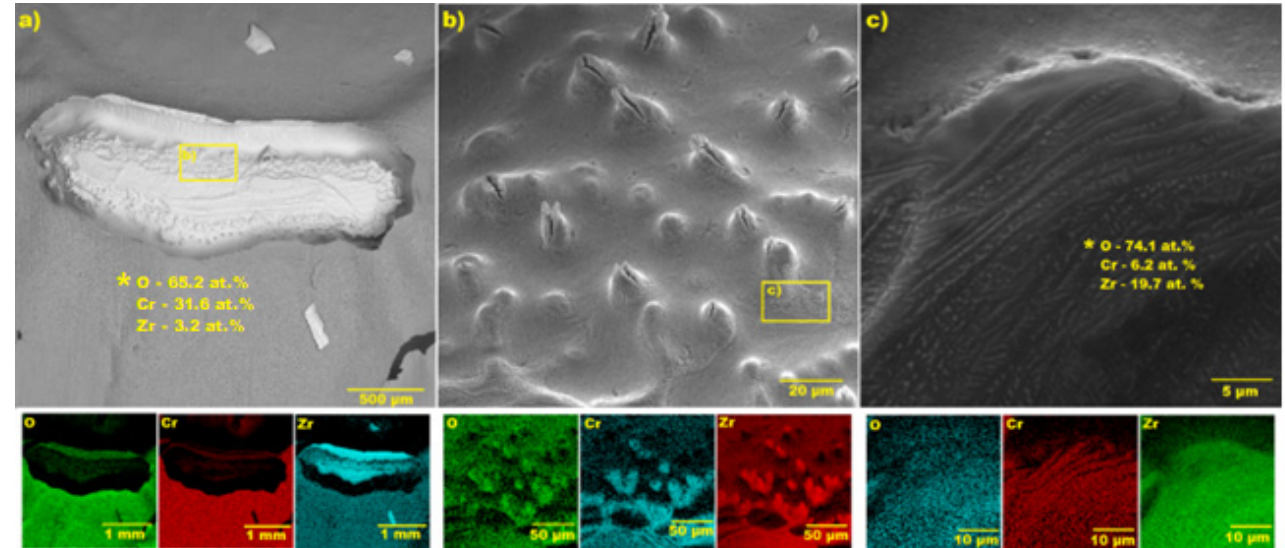
Figure 13. Cross-section SEM microstructure of the ZrO 2 /Cr-100 sample after oxidation in water steam at 1400 °C for 120 s obtained at different magnification: ( a )—×300; ( b )—×1500; ( c )—×10,000. Points (*) indicate the positions of EDS measurements.